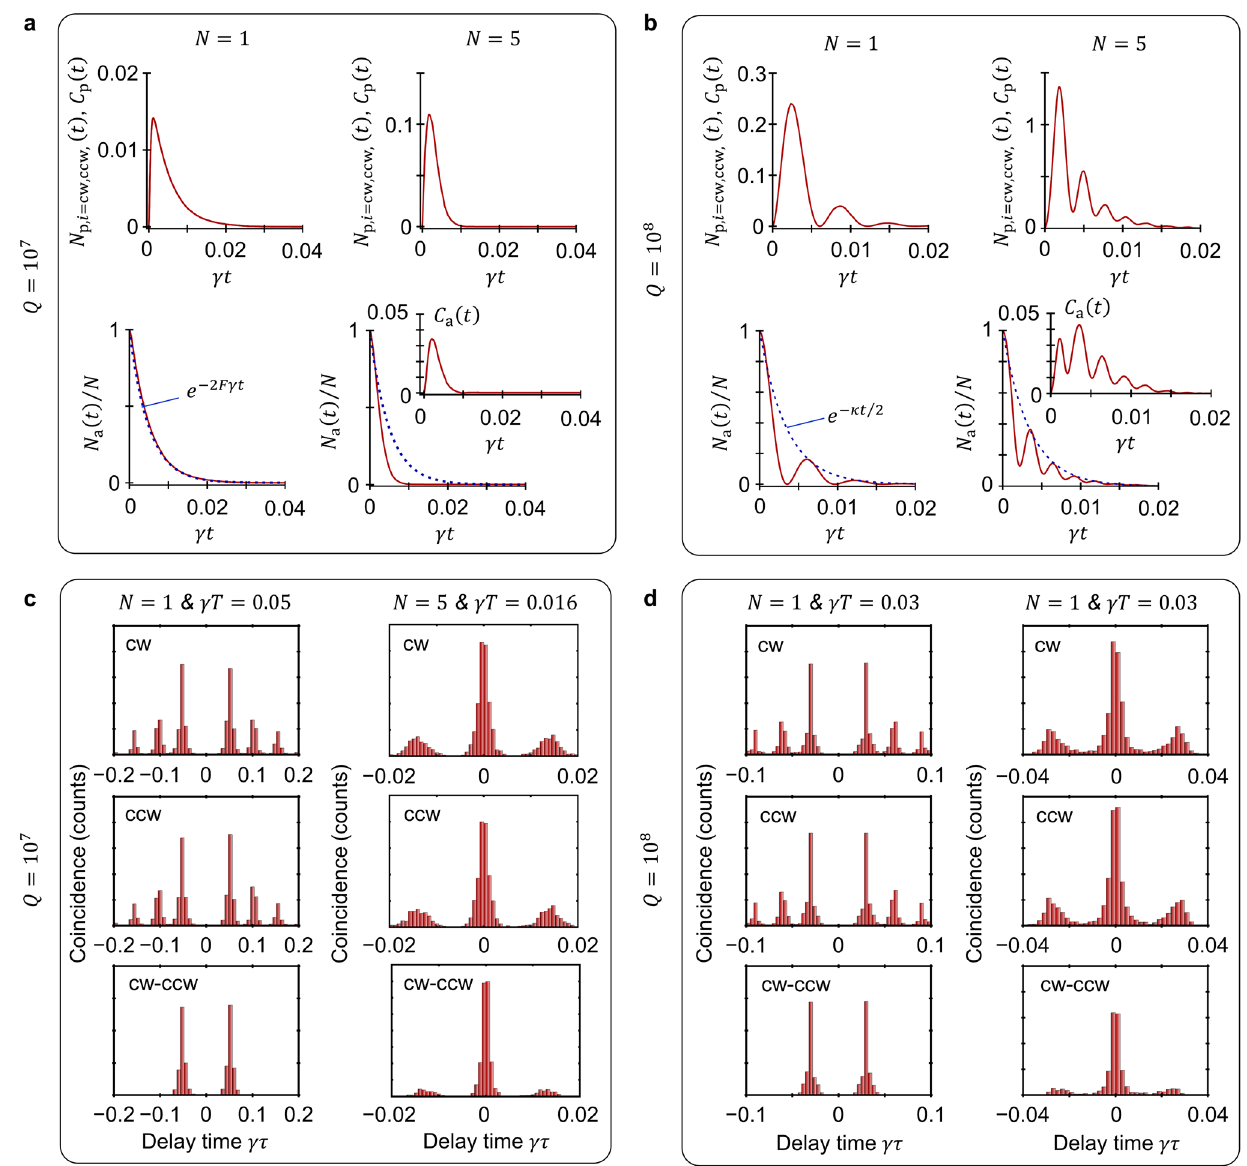
Figure 3. Spontaneous emission of N atoms confined in the vicinity of a microsphere. ( a ) Intracavity photon numbers N p,i CW,CCW ( t ) , intermode correlation C p ( t ) , atomic population N a ( t ) in | P � and interatomic = 10 7 , κ 2 π 44 MHz) microcavity. The correlation C a ( t ) of the coupled system with a fast ( Q = = × 10 2 . All atoms are initially prepared in P corresponding Purcell factor is F and the microcavity contains zero | � = photons. ( b ) Time evolutions of N p,i CW,CCW ( t ) , C p ( t ) , C a ( t ) and N a ( t ) for the system in the slow-microcavity = 10 8 . ( c , d ) Coincidence statistics of the Hanbury Brown–Twiss detection, where the atoms are regime with Q = P repeatedly prepared in by a sequence of short resonant light π-pulses. The period T of light pulse sequence is | � 0.05 for N = 1 and γ T 0.016 for N = 5 ( γ T 0.03 for both N = 1 and N = 5) in the fast-microcavity set at γ T = = = (slow-microcavity) regime. All plots are obtained by using the MCWF